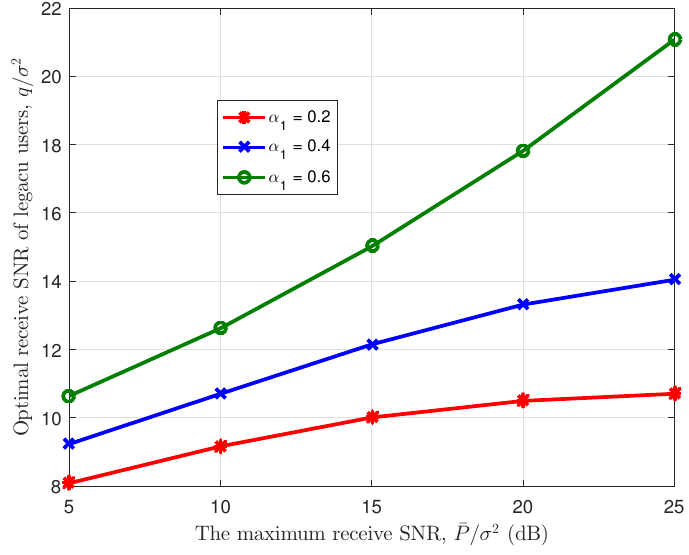
Figure 6. Optimal legacy satellite receive SNR vs. maximum IoT receive SNR.